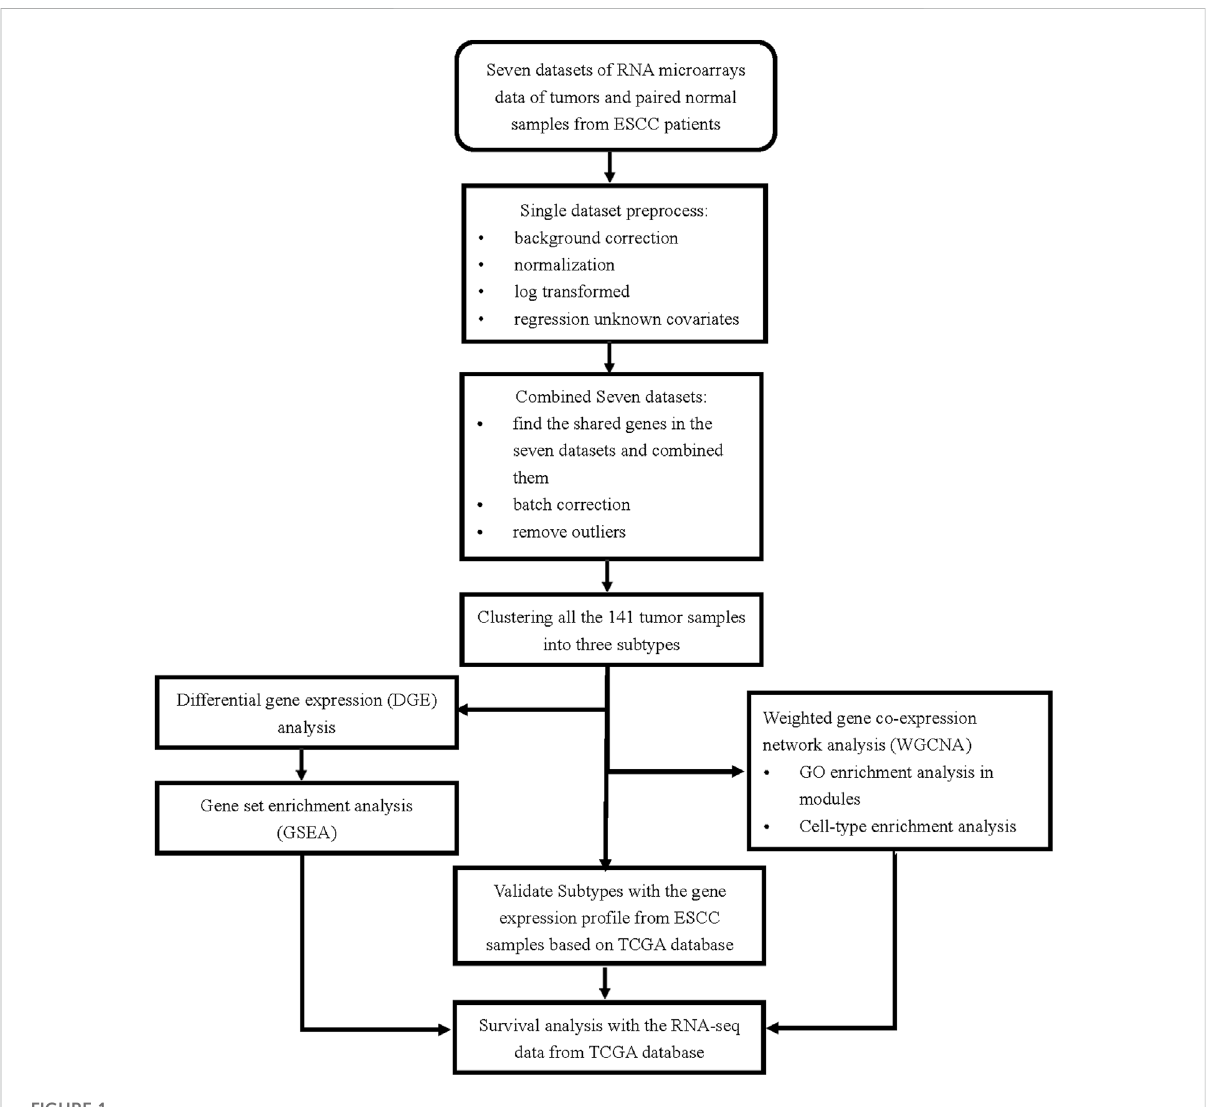
FIGURE 1 The pipeline of this